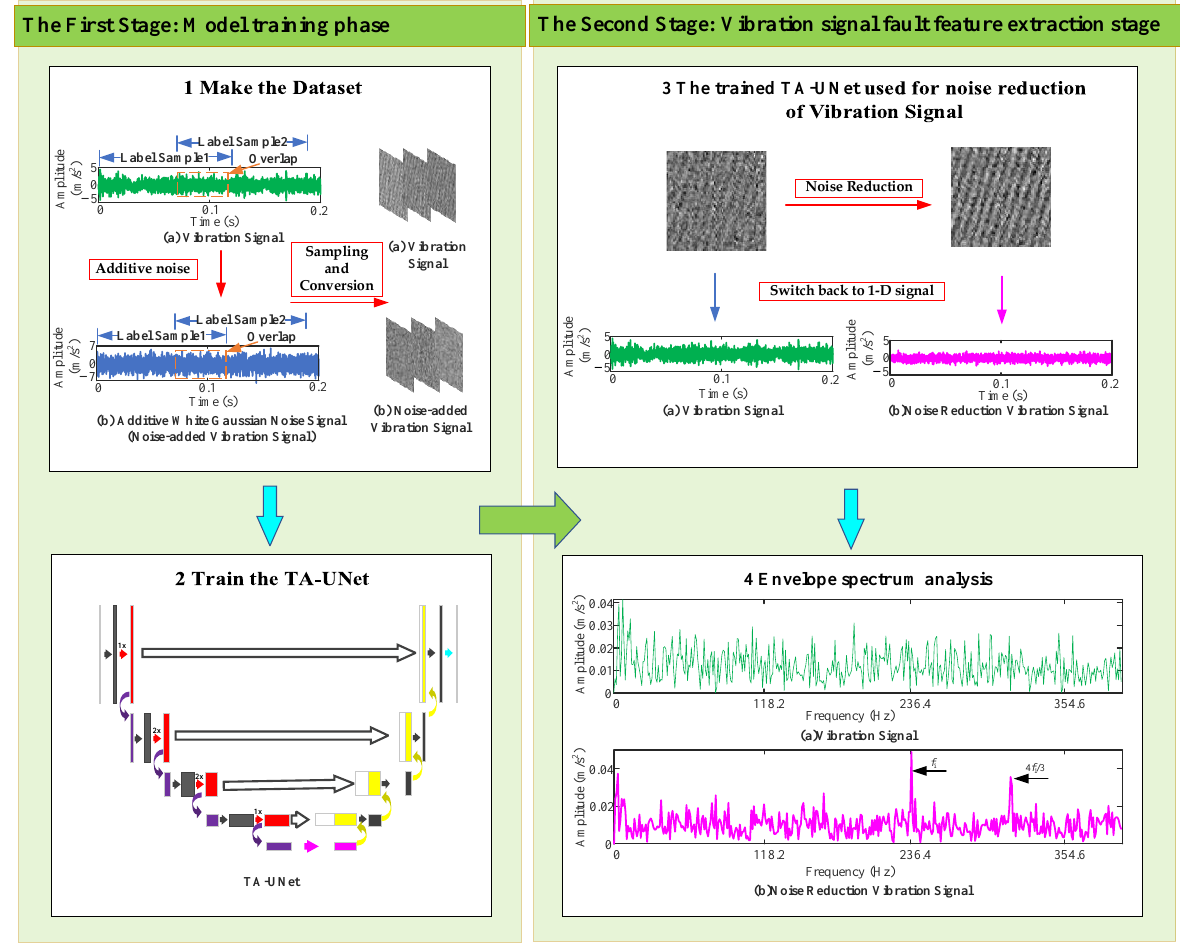
Figure 5. Early fault diagnosis method of rolling bearing based on TA-UNet. The fault diagnosis method is divided into two stages. In the first stage, the vibration signal and vibration signal with additive white gaussian noise (noise-added vibration signal) are sampled by sliding window and then the sample is converted into the gray matrix to make the dataset. Finally, the dataset is used to train the TA-UNet, so it can learn to extract the hidden feature of the noise-added vibration signal and realize the noise-reduced vibration signal. Because the implicit features of vibration and noise-added vibration signal have certain invariances, this paper believes that the network has learned how to extract the implicit feature of vibration signals (how to reduce the noise of vibration signals) to a certain extent. In the second stage, the trained network is used to reduce the noise of the vibration signal, and envelope spectrum analysis of the noise-reduced vibration signal is conducted to diagnose bearing faults. The fault diagnosis method can be expressed by Equation (15). where F TA ( X N ) denotes the noise reduction of the noisy vibration signal by the TA-UNet, ( X ) denotes the noise reduction of the vibration signal by the trained F (cid:48) TA